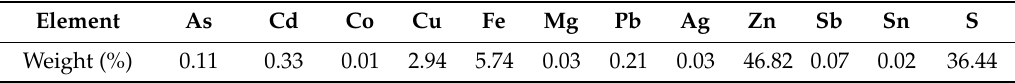
Table 2. Results of the Inductively Coupled Plasma Spectroscopy on the Zn concentrate sample.